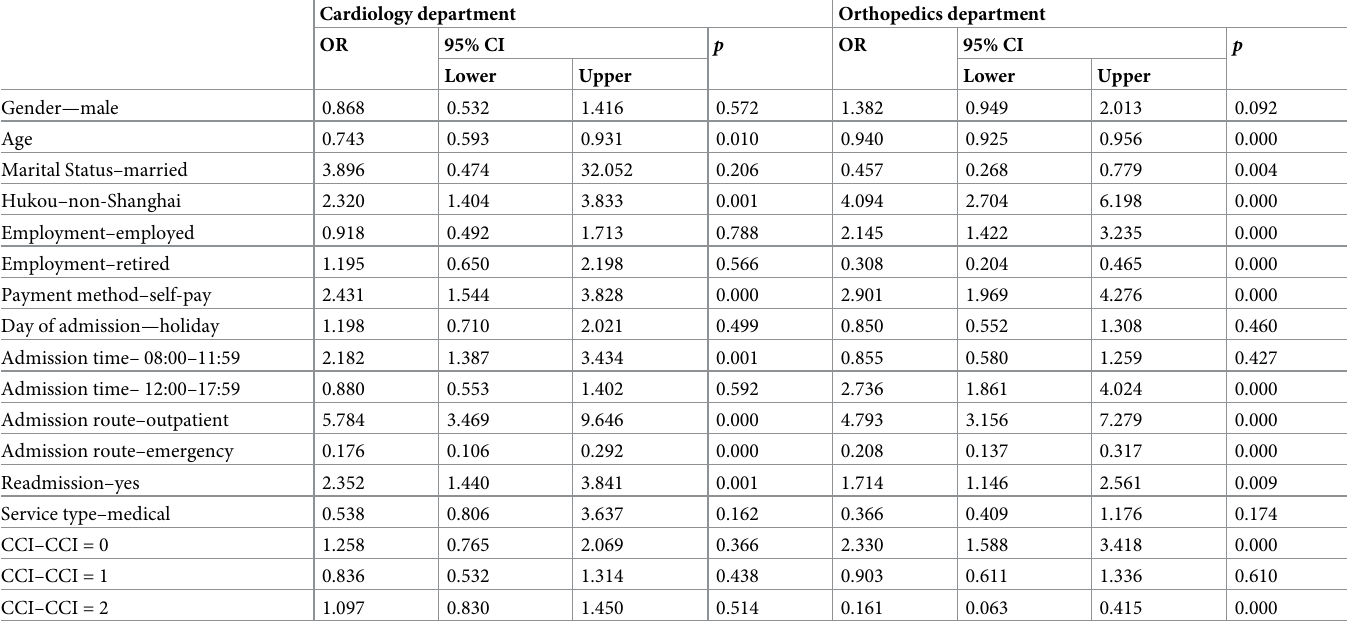
Table 2. Univariate logistic regression analysis results.